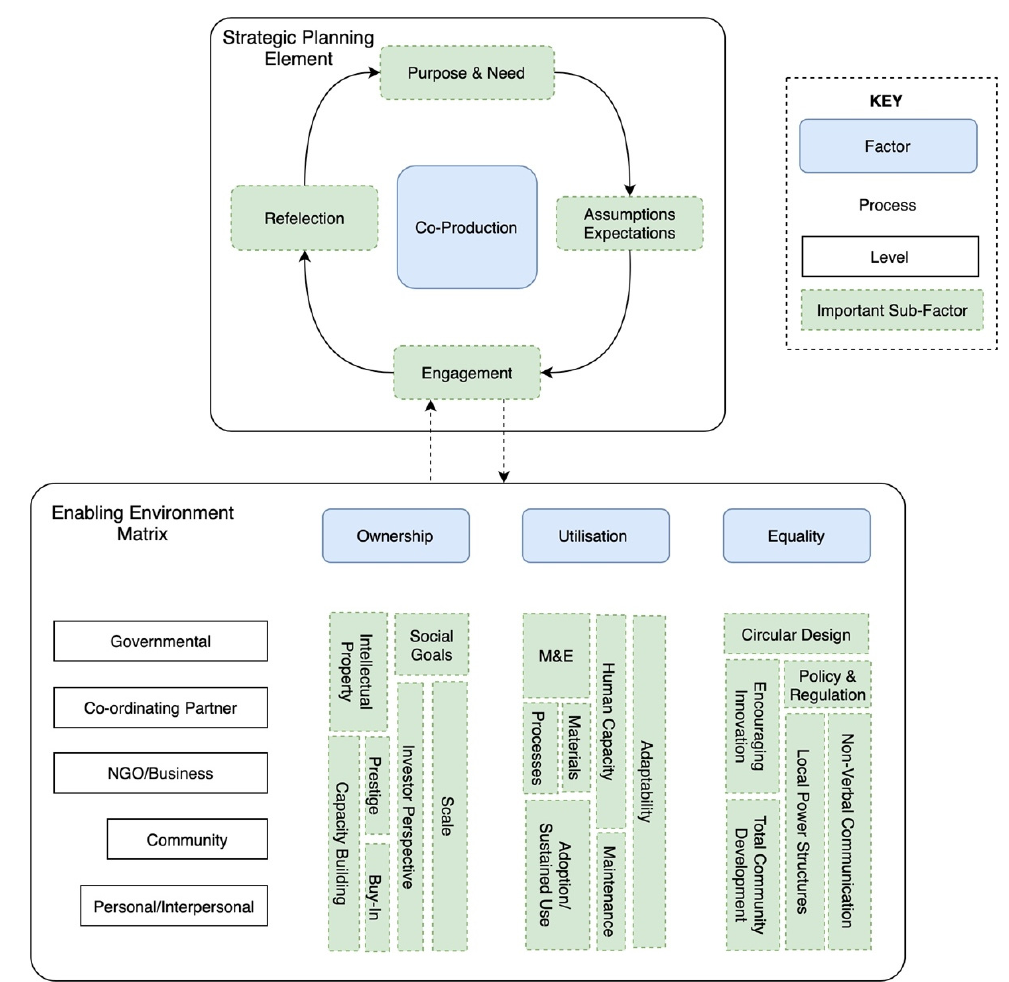
Figure 1. The TIME